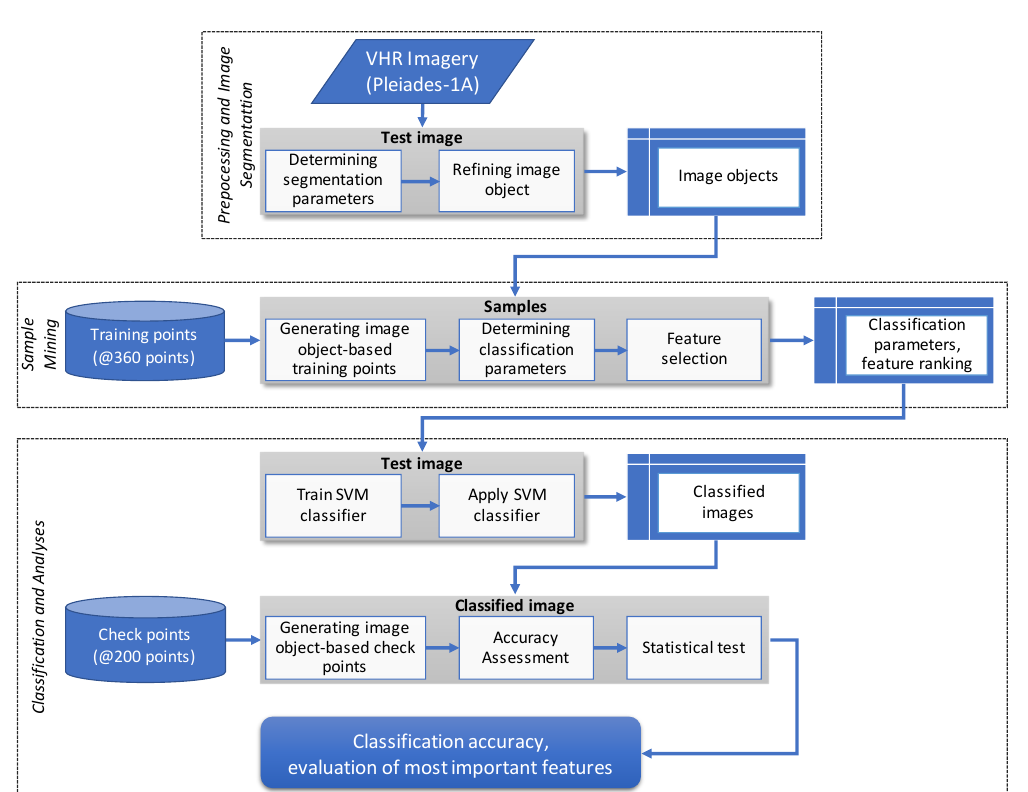
Figure 2. Research flowchart depicting the important steps in this classification scheme.